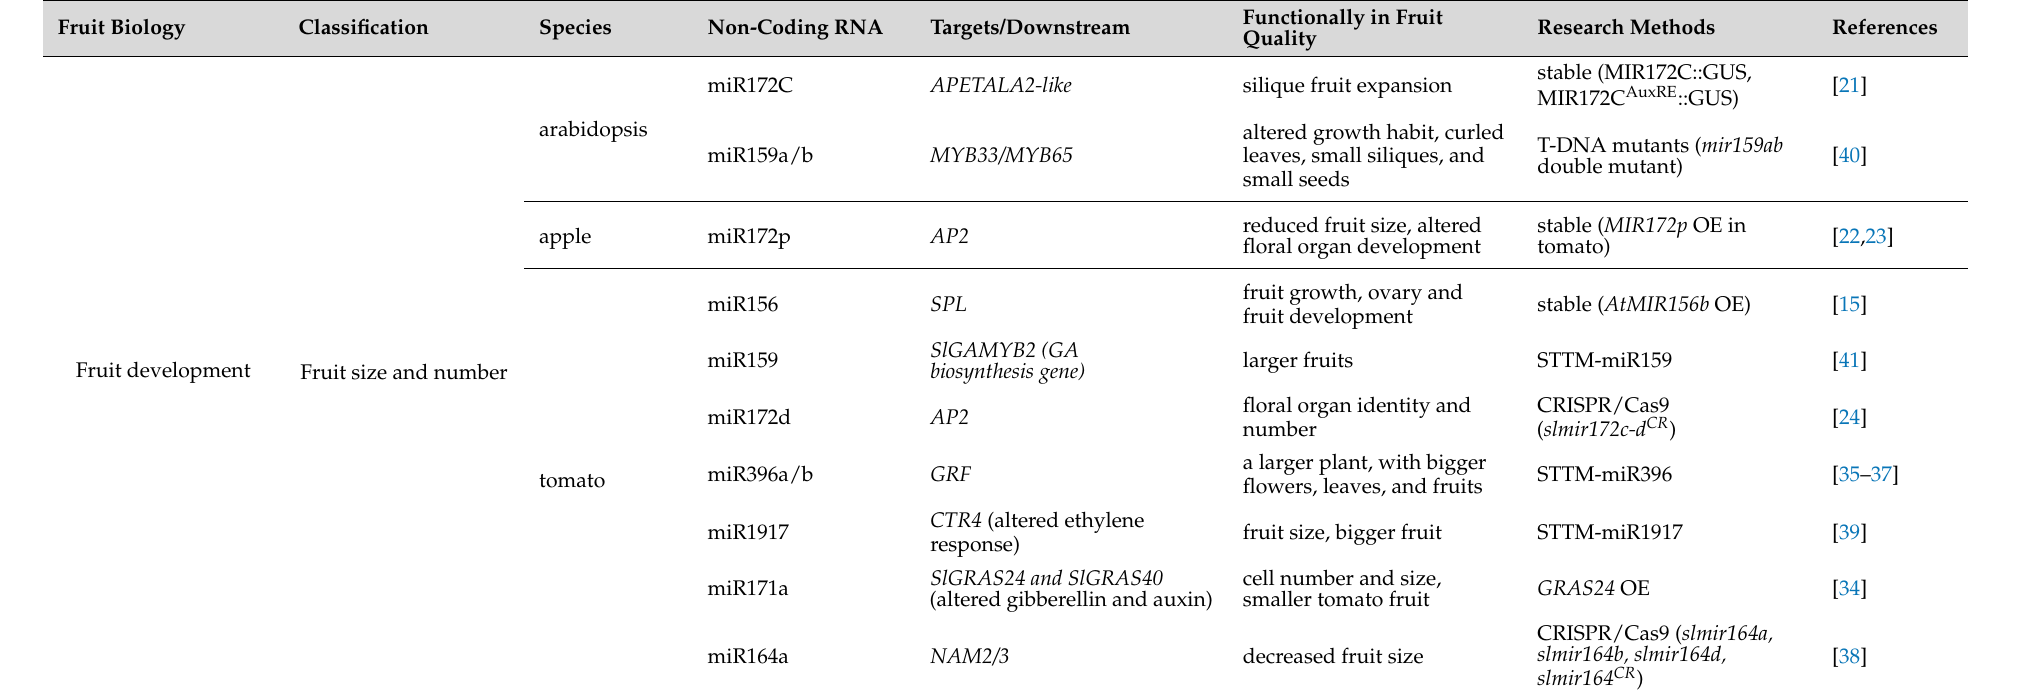
Table 1. miRNAs and lncRNAs with functional verification in fruit